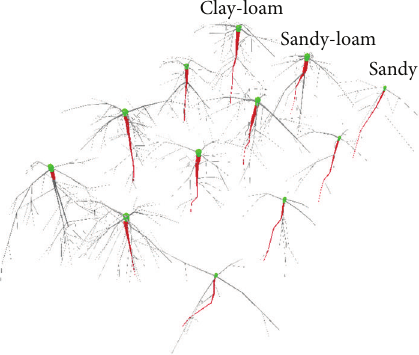
Figure 5: Digitized Jatropha curcas root systems grown in three different